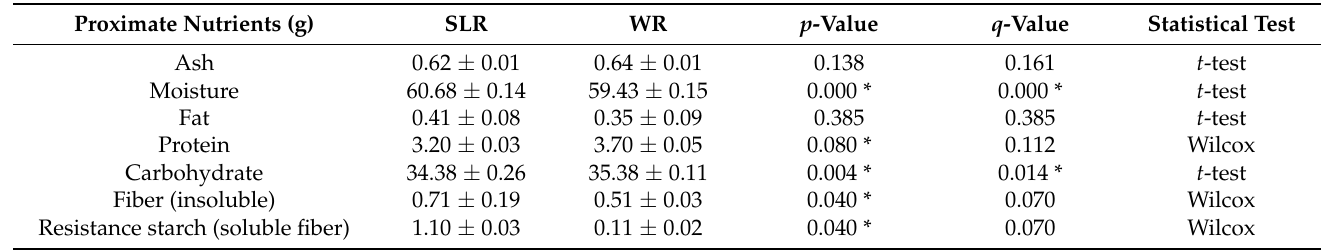
Table 1. Proximate nutritional content of cooked brown rice (SLR) versus white rice (WR) per 100 g (g)